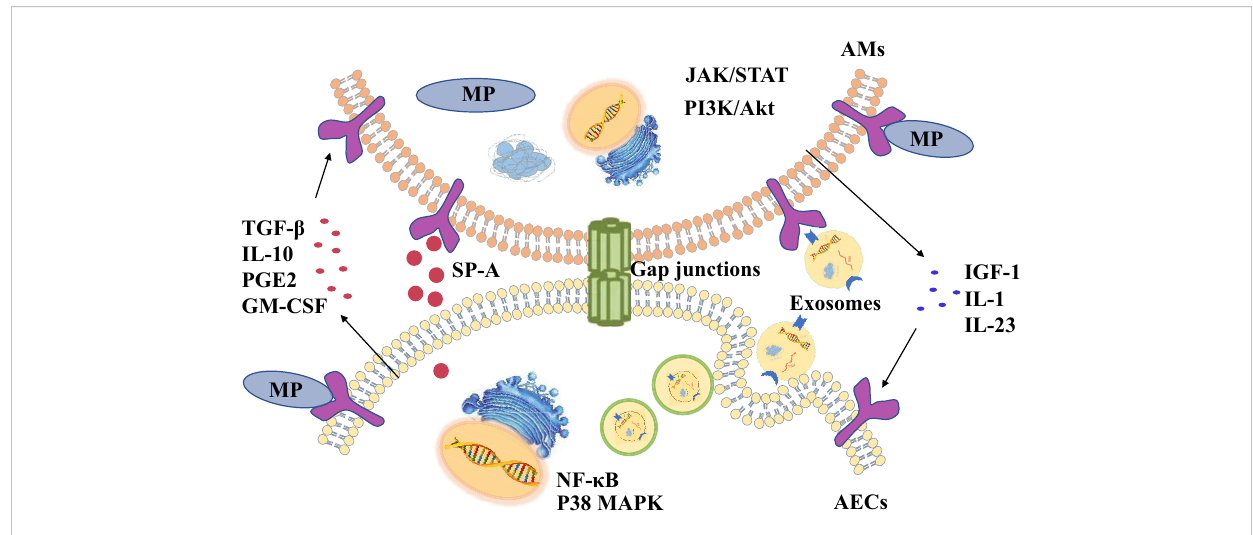
FIGURE 1 There are four ways of communication between alveolar macrophages (AMs) and alveolar epithelial cells (AECs) during Mycoplasma pneumoniae (MP) infections, including cytokines, exosomes, surfactant-associated protein A (SP-A) and gap junction